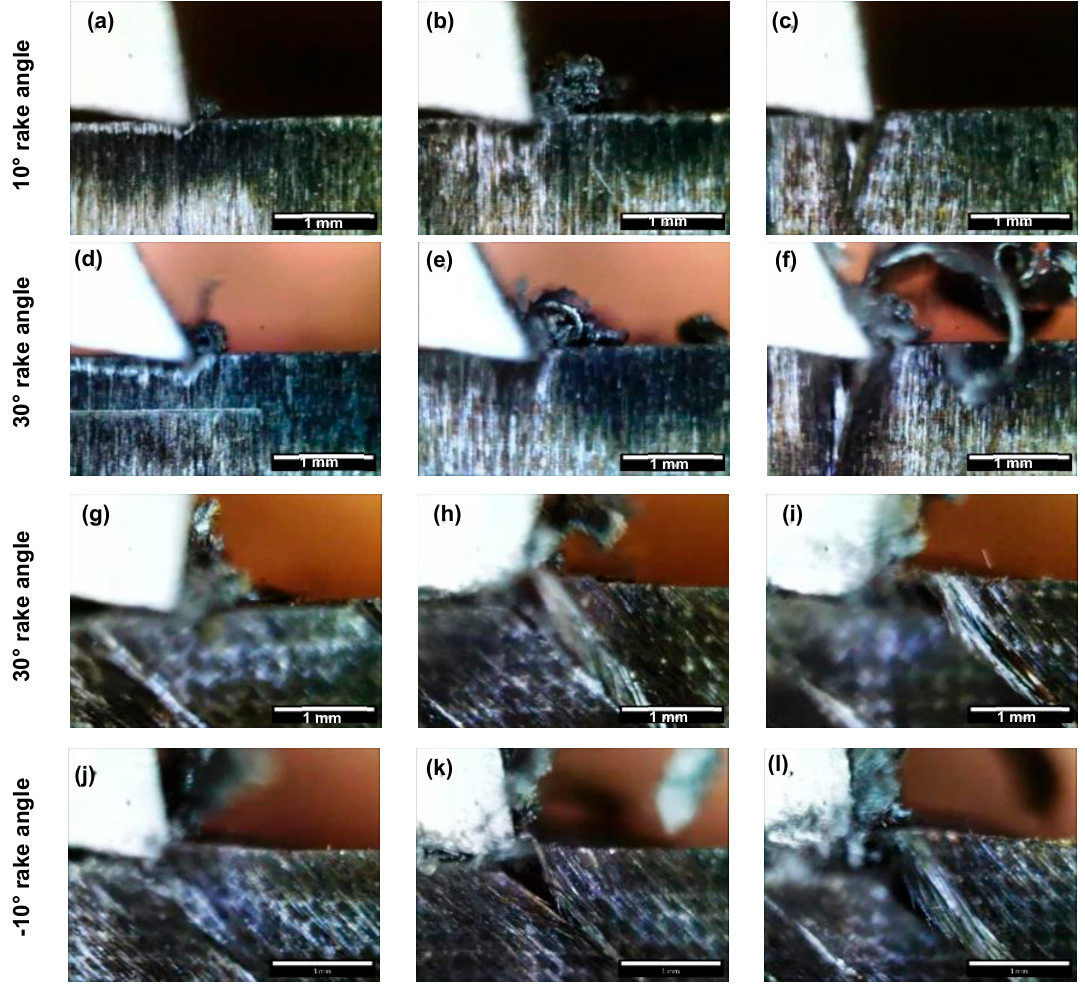
Figure 5. Chip formation at a depth of cut of ( a , d , g , j ) 50 µ m, ( b , e , h , k ) 100 µ m and ( c , f , i , l ) 150 µ m. (The white scale bar = 1mm).